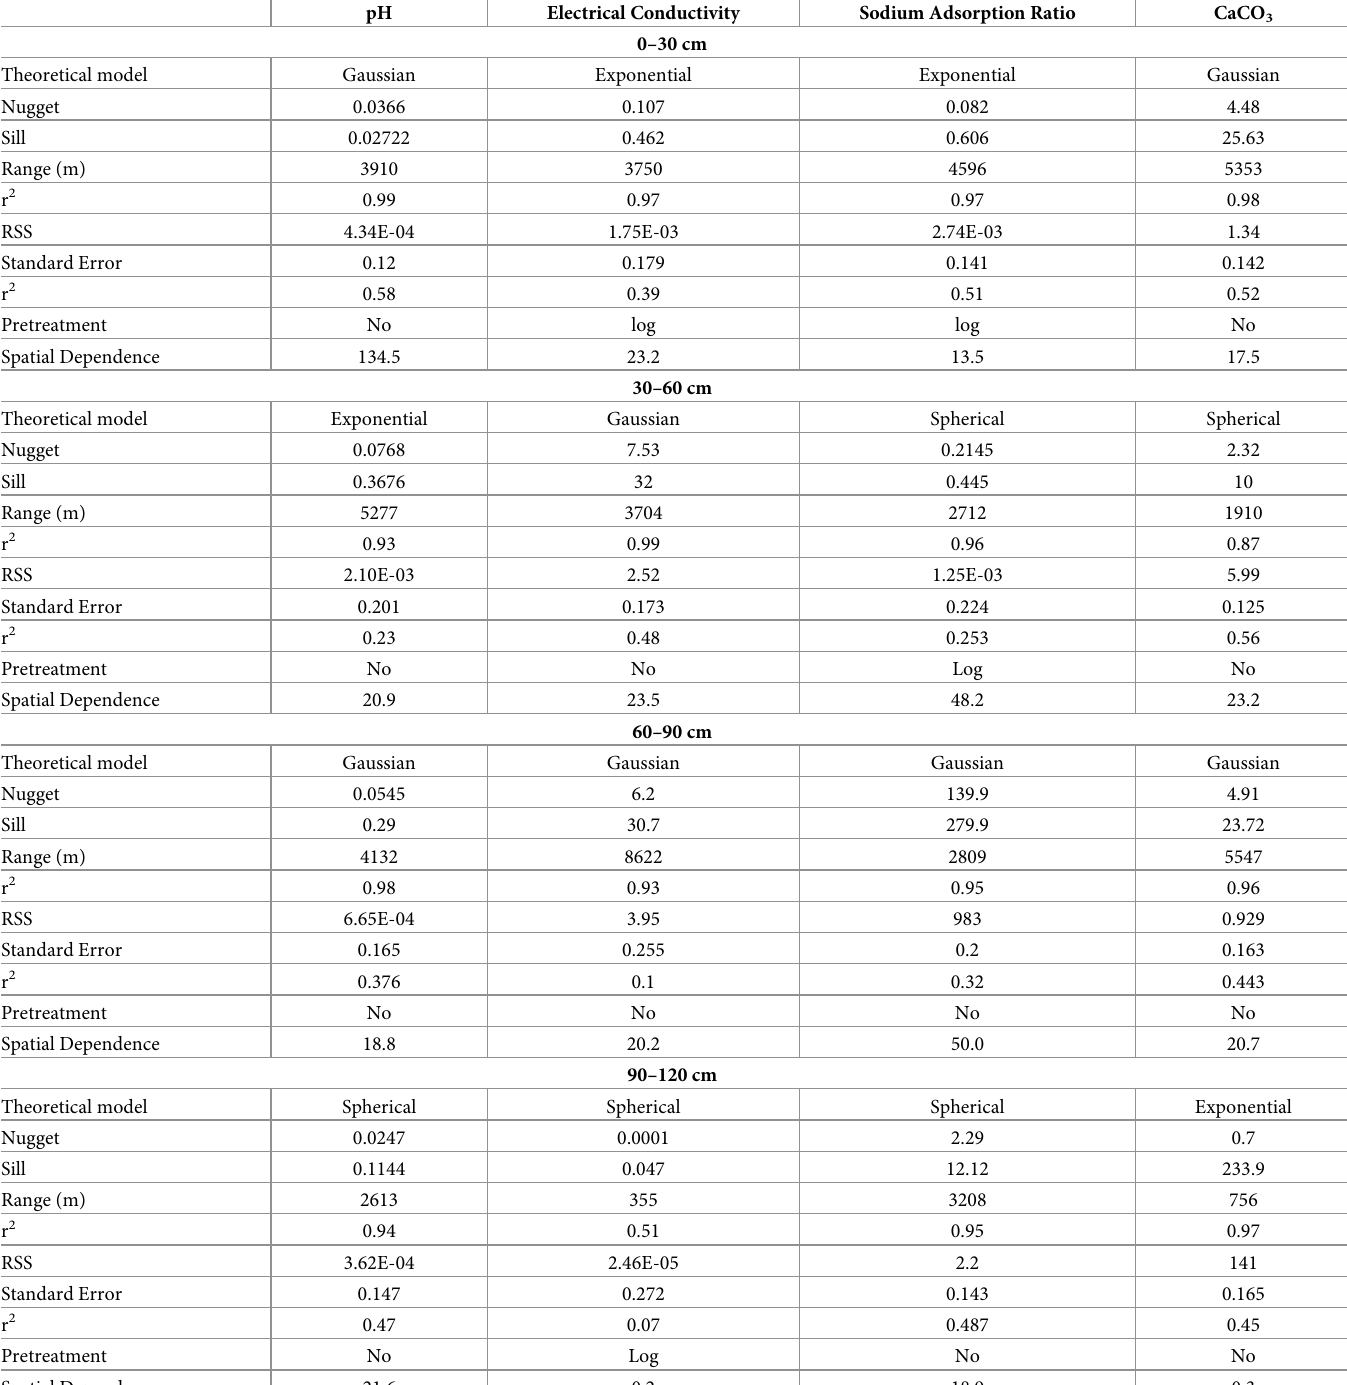
Table 4. Geostatistical analysis results for various parameters determined in the